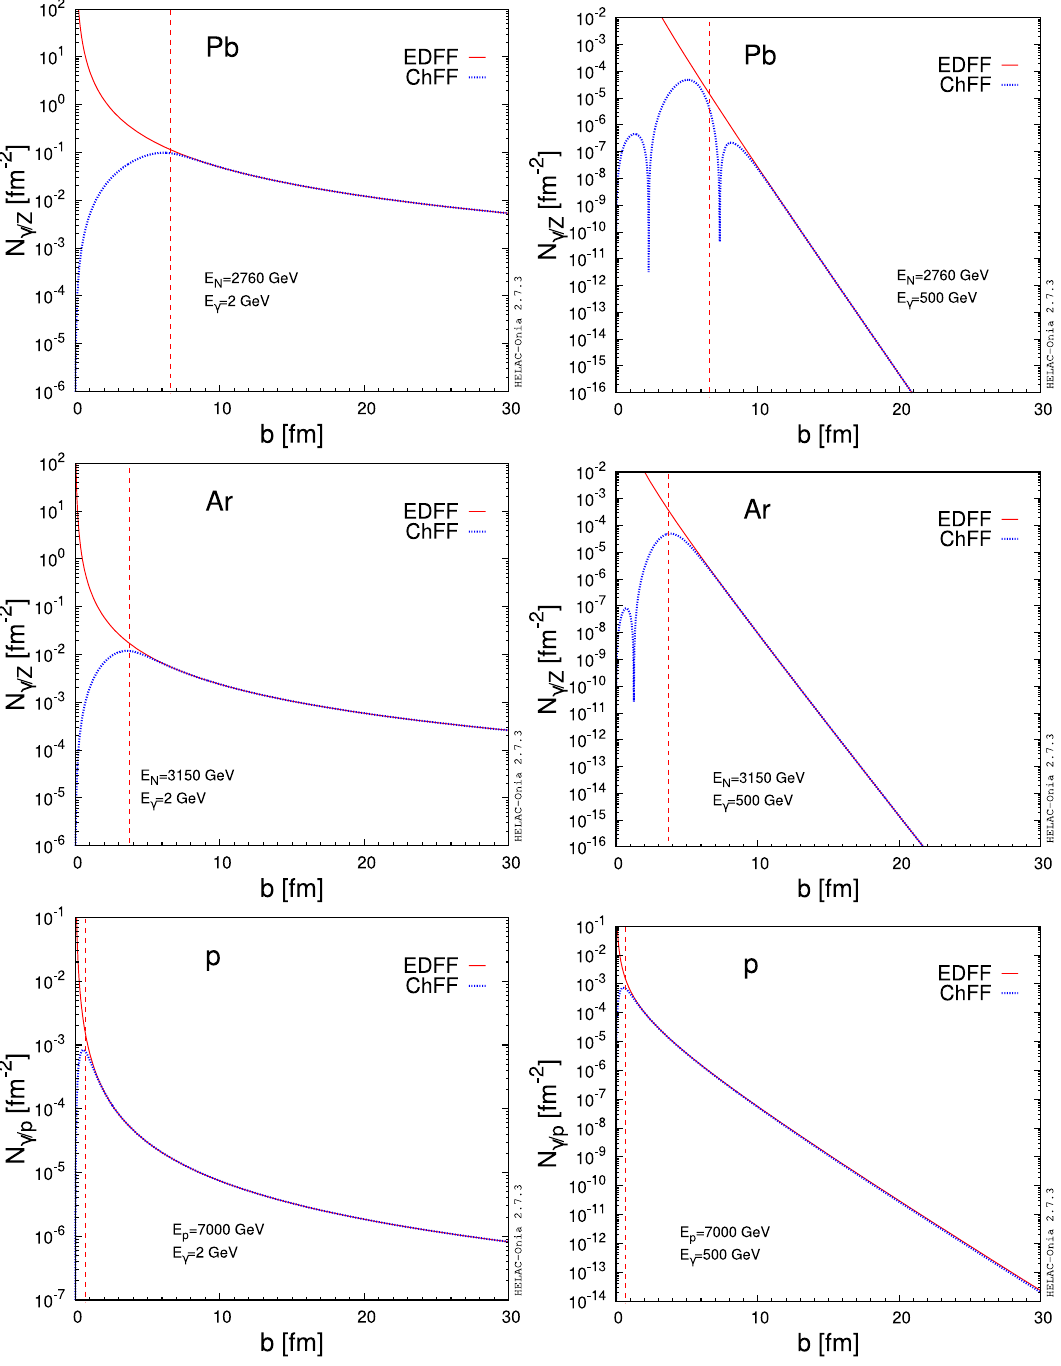
Figure 3 . Comparison of the photon number densities at low ( E (cid:13) = 2 GeV, left) and high ( E (cid:13) = 500 GeV, right) energies as functions of the impact parameter b , obtained with the two form factors considered here (EDFF, red solid, and ChFF, blue dashed) for Pb ions at 2 : 76 TeV (top), Ar at 3 : 15 TeV (middle), and proton at 7 TeV (bottom). The vertical dashed red lines at b (cid:25) R A indicate the threshold lower-limit imposed on the integral of the EDFF